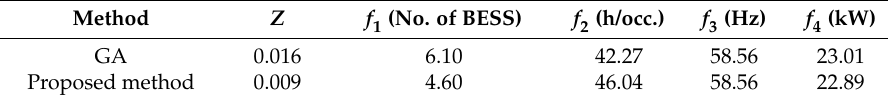
Table 3. Preferred values (cid:1858) ℓ ∗ and corresponding weighting factors.